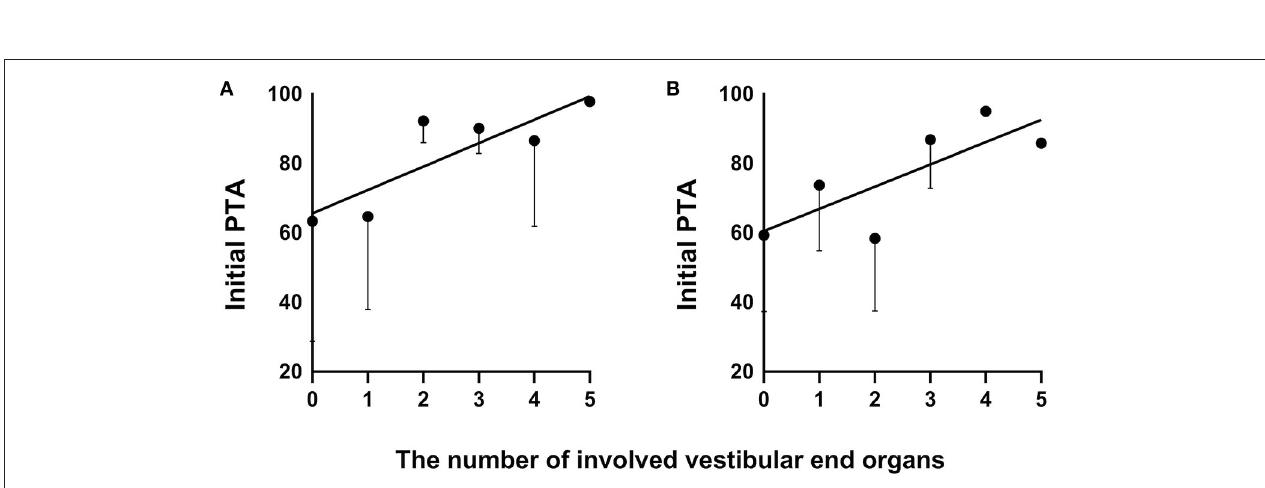
FIGURE 3 | The correlation of the number of involved vestibular end organs and initial PTA in the SSNHL vertigo group (A) and non-vertigo group (B) . SSNHL, sudden sensorineural hearing loss; PTA, pure-tone